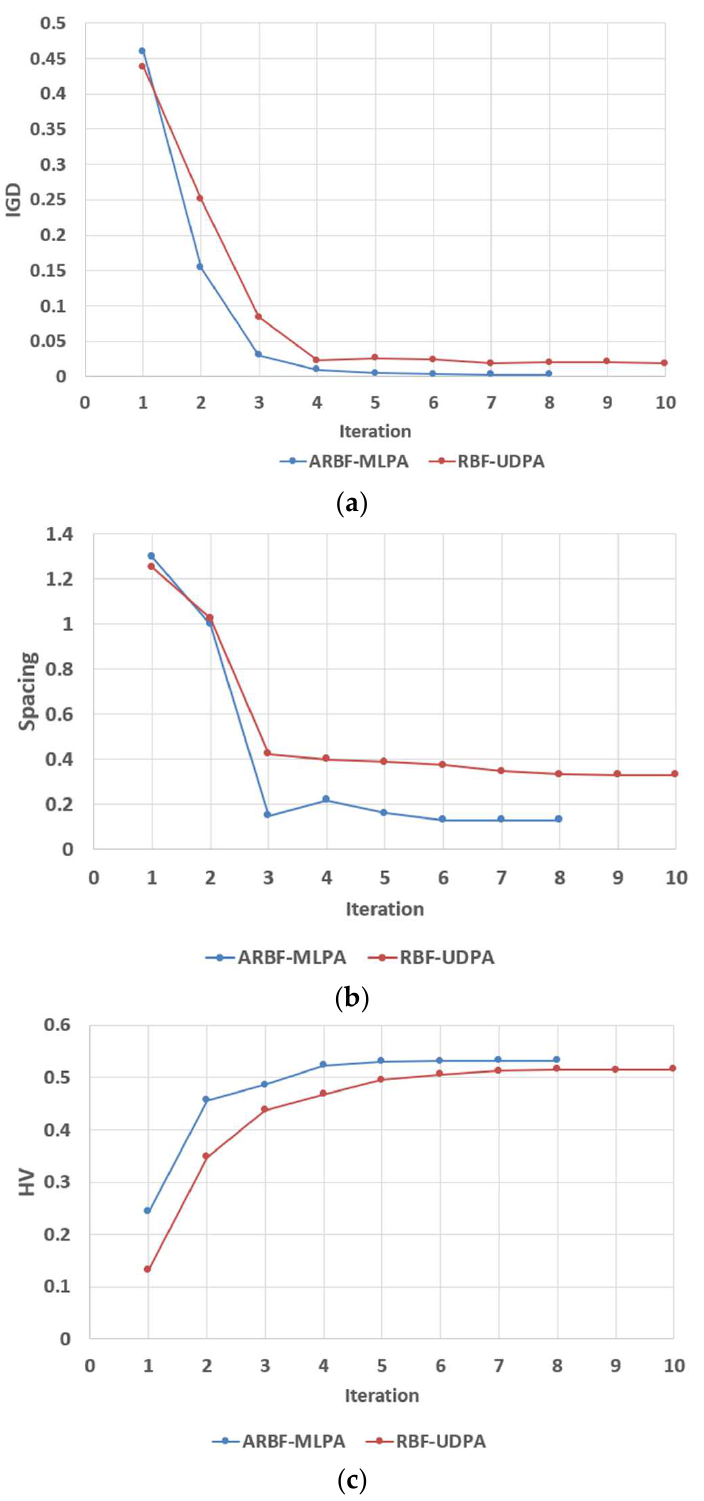
Figure 4. ( a ) IGD under function ZDT1. ( b ) Spacing under function ZDT1. ( c ) HV under function ZDT1.